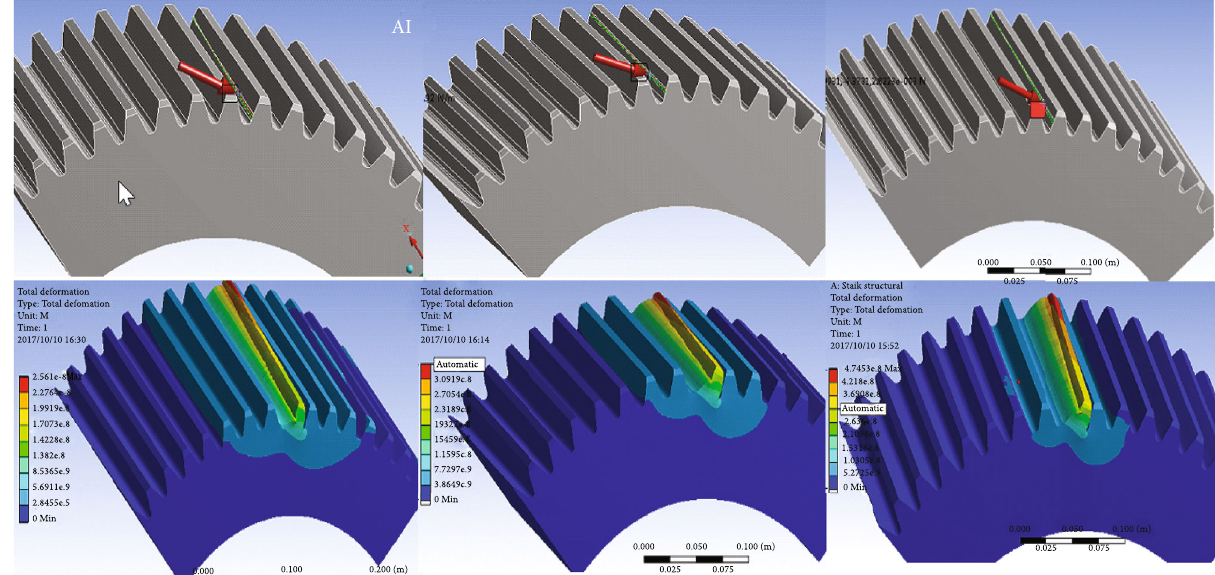
Figure 5: The loaded process diagram in ANSYS.